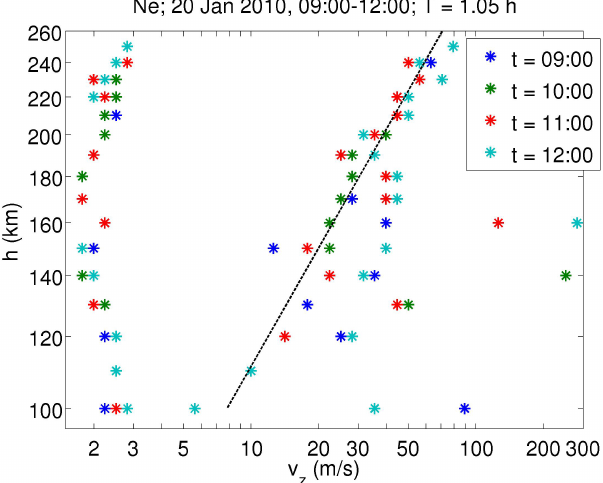
Figure 4. The phase velocities as a function of altitude as in Fig. 3 for 09:00–12:00 and T = 1.05h, and a curve fitted to all results to-